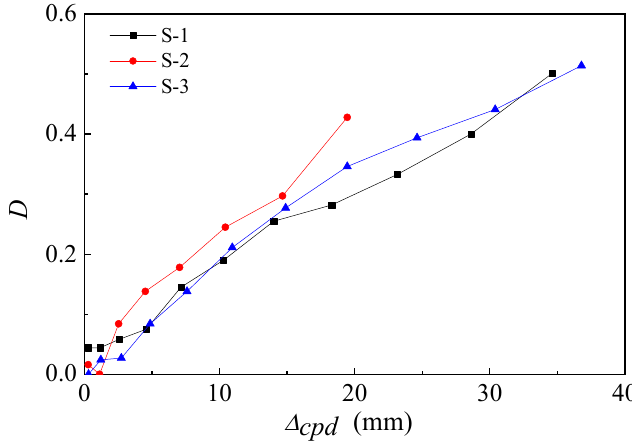
Figure 13. Damage modulus curve.